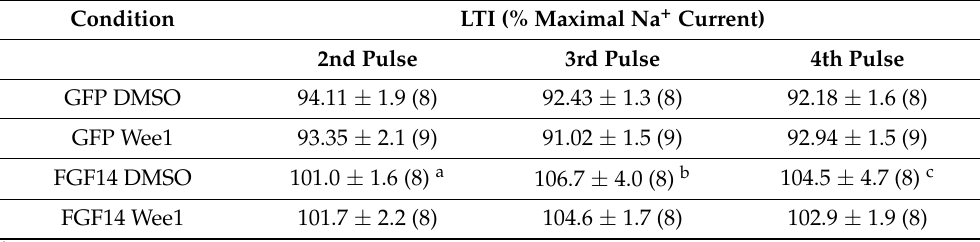
Table 4. Effects of Wee1 inhibitor II on entry of Na v 1.6 channels into long-term inactivation †